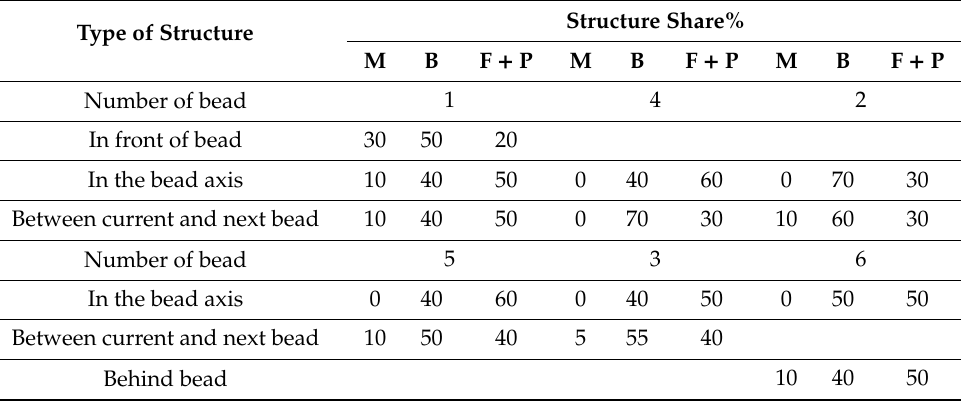
Table 6. Shares of structures in the surfaced welds on plate